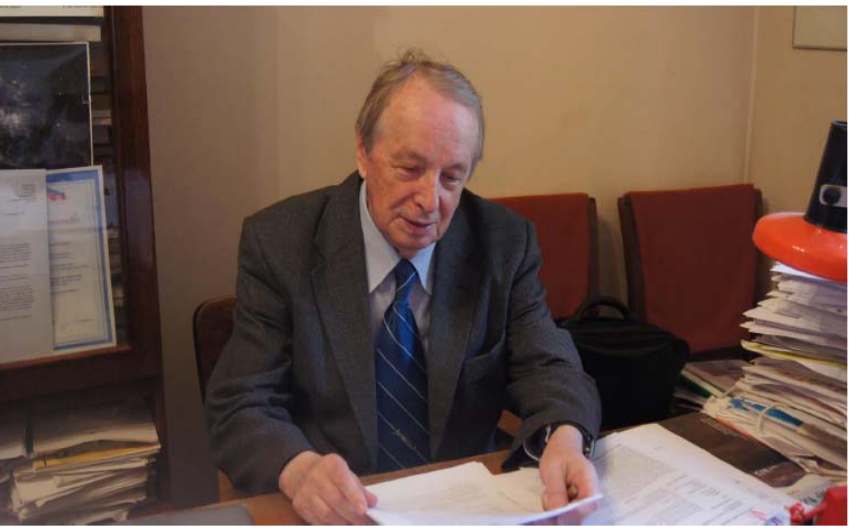
Figure 1. Prof. Dr. Yuri N. Gnedin (13 August 1935–27 March 2018) is working in his office at Pulkovo Observatory of the Russian Academy of